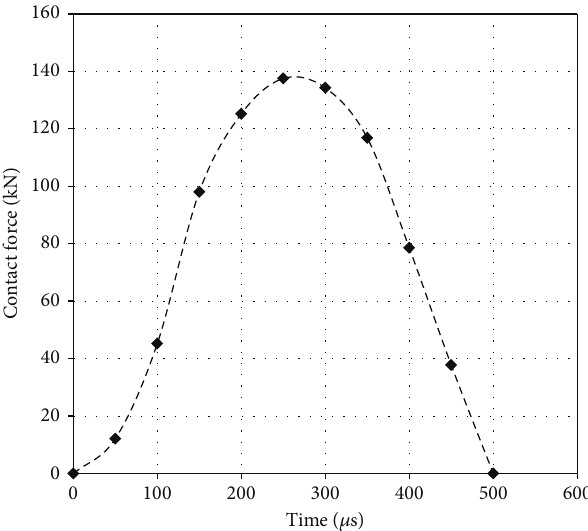
Figure 12: Impact force of the swing hammer on the bar supporting the